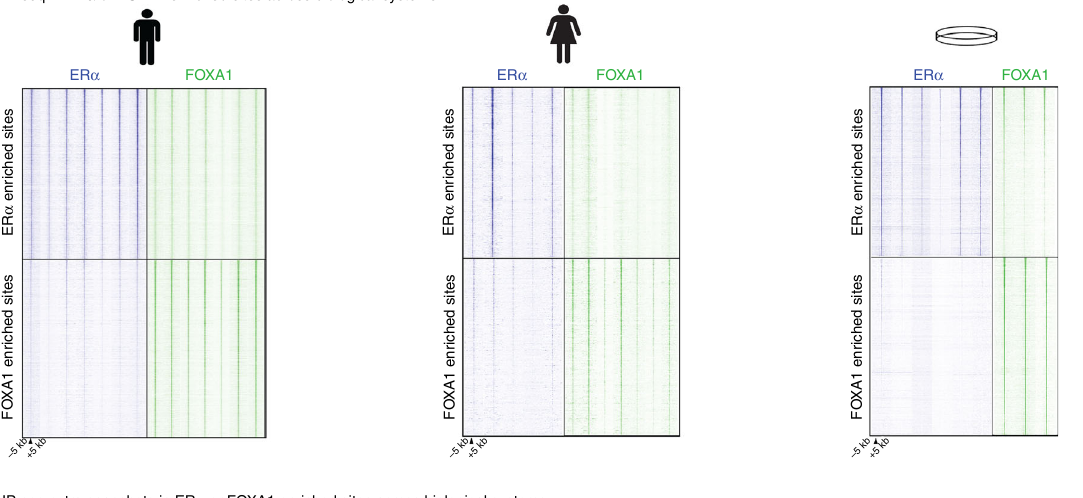
ChIP-seq extra snapshots in ER α or FOXA1 enriched sites across biological systems